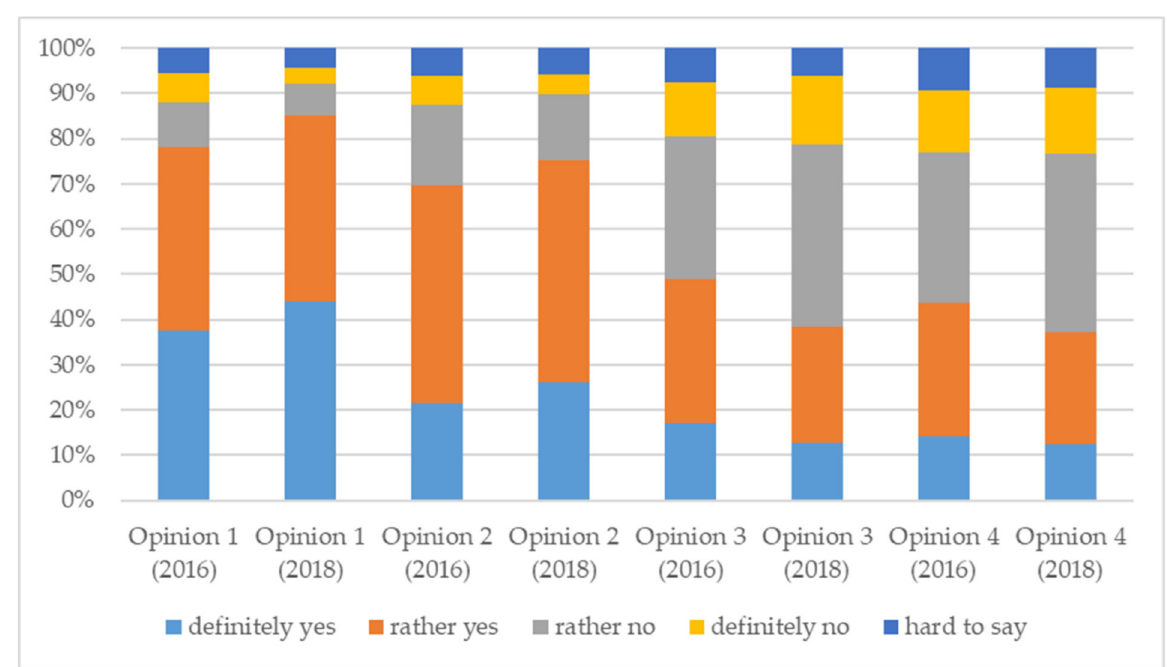
Figure 8. Support for the climate policy in Poland: Opinion 1: Poland should support the European Union in its efforts to reduce carbon dioxide emissions. Opinion 2: Poland should support actions to help countries that have been victims of climate change. Opinion 3: Poland is too poor to afford special programs aimed at combating climate change. Opinion 4: Poland’s contribution to climate change is so small that the actions taken by Poland will change nothing. Source: developed by the authors, based on Reference